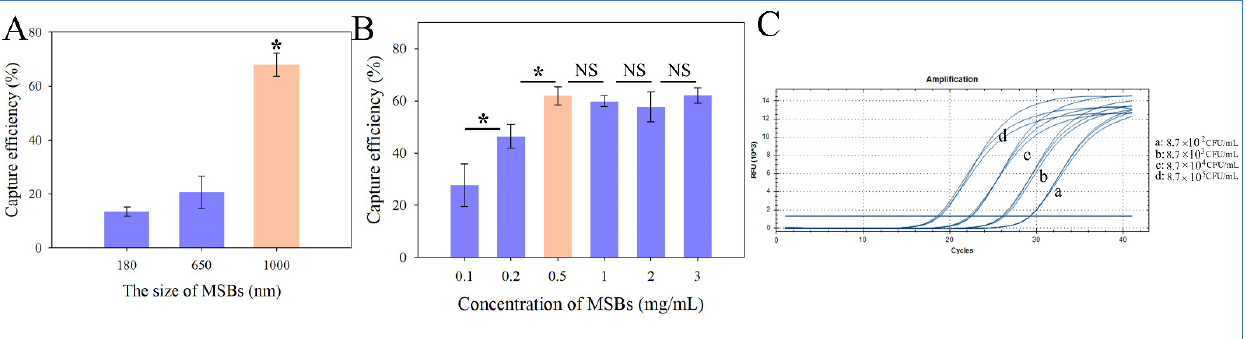
Figure 3. Optimization on amount and size of MSBs. ( A ) Capture e ffi ciency for di ff erent sizes of MSBs (N = 3). ( B ) Capture e ffi ciency for di ff erent concentrations of MSBs (N = 3). ( C ) Real-time qPCR MSBs (N = 3). ( B ) Capture efficiency for different concentrations of MSBs (N = 3). ( C ) Real-time results of DNA extracted from di ff erent concentrations of samples using the biosensor (N = 3). * qPCR results of DNA extracted from different concentrations of samples using the biosensor (N = 3). indicates signi fi cant di ff erence at p < 0.05. “NS” indicates no signi fi cant di ff erences. * indicates significant difference at p < 0.05. “NS” indicates no significant